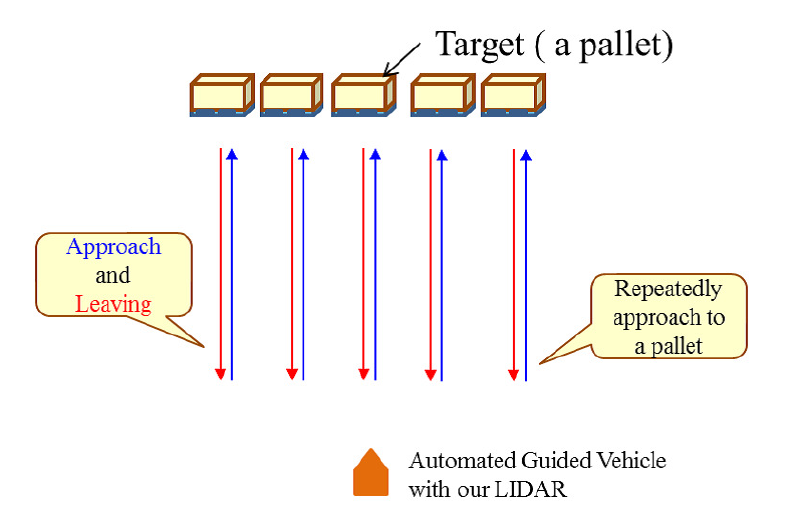
Figure 8. Example of assumed scenario 1 for AGV. An AGV equipped with SPAD LiDAR automatically approaches a pallet and transports the pallet to another location.